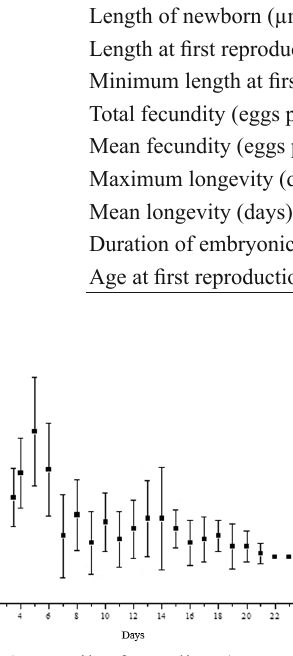
Figure 2 - Daily fecundity (mean ± standard deviation) of P. roseola during its life-cycle, when cultured at 25±1°C with abundant live algae as food. Data points represent mean values for 9 isolated